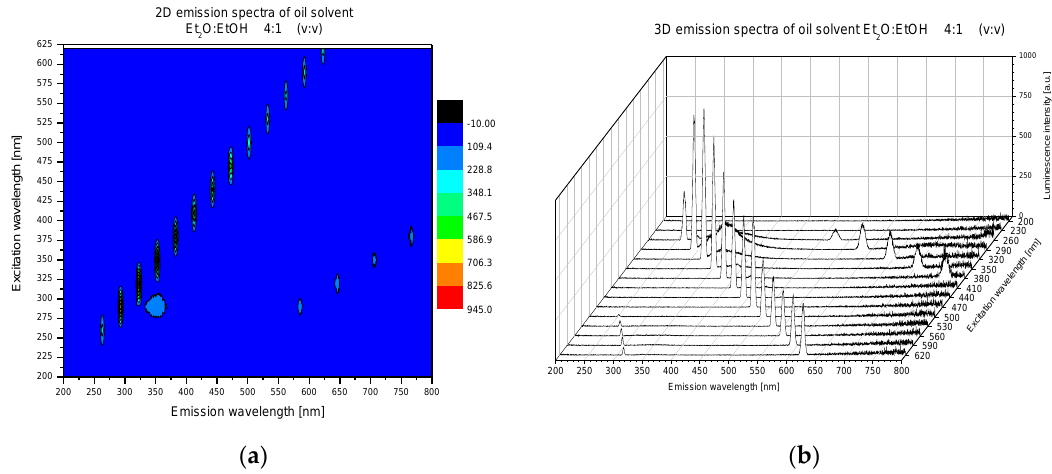
Figure 1. Correlative spectra of solvent (diethyl ether/ethanol, 4/1, v / v ) as a blank probe: in two- (2D) ( a ) and three-dimensional (3D) ( b ) presentation.